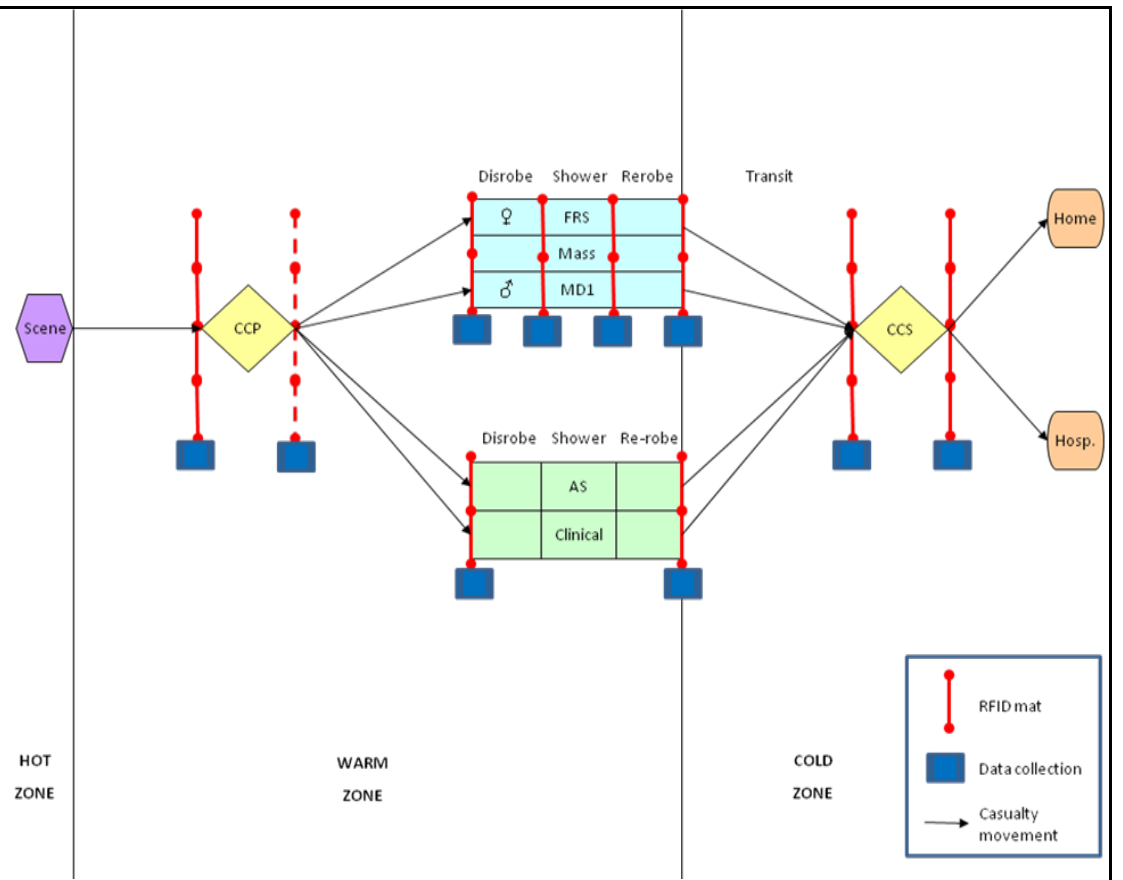
Figure A1. For the purposes of this analysis the warm zone extended to the exits of both the MD1 and clinical decontamination units. The casualty collection point (CCP) extended to the entrance of both decontamination units making the dashed radio frequency identification (RFID) detection mat redundant. The outer lanes of the MD1 were used to process (fe)male ambulant casualties whereas the middle lane was for non-ambulant casualties if required but only when specifically configured and not simultaneously with mass decontamination. Human evaluators captured the disrobe, shower and re-robe timings within the clinical decontamination unit. The exit to the casualty clearing station (CCS) was considered the exit from the system although the police did perform subsequent